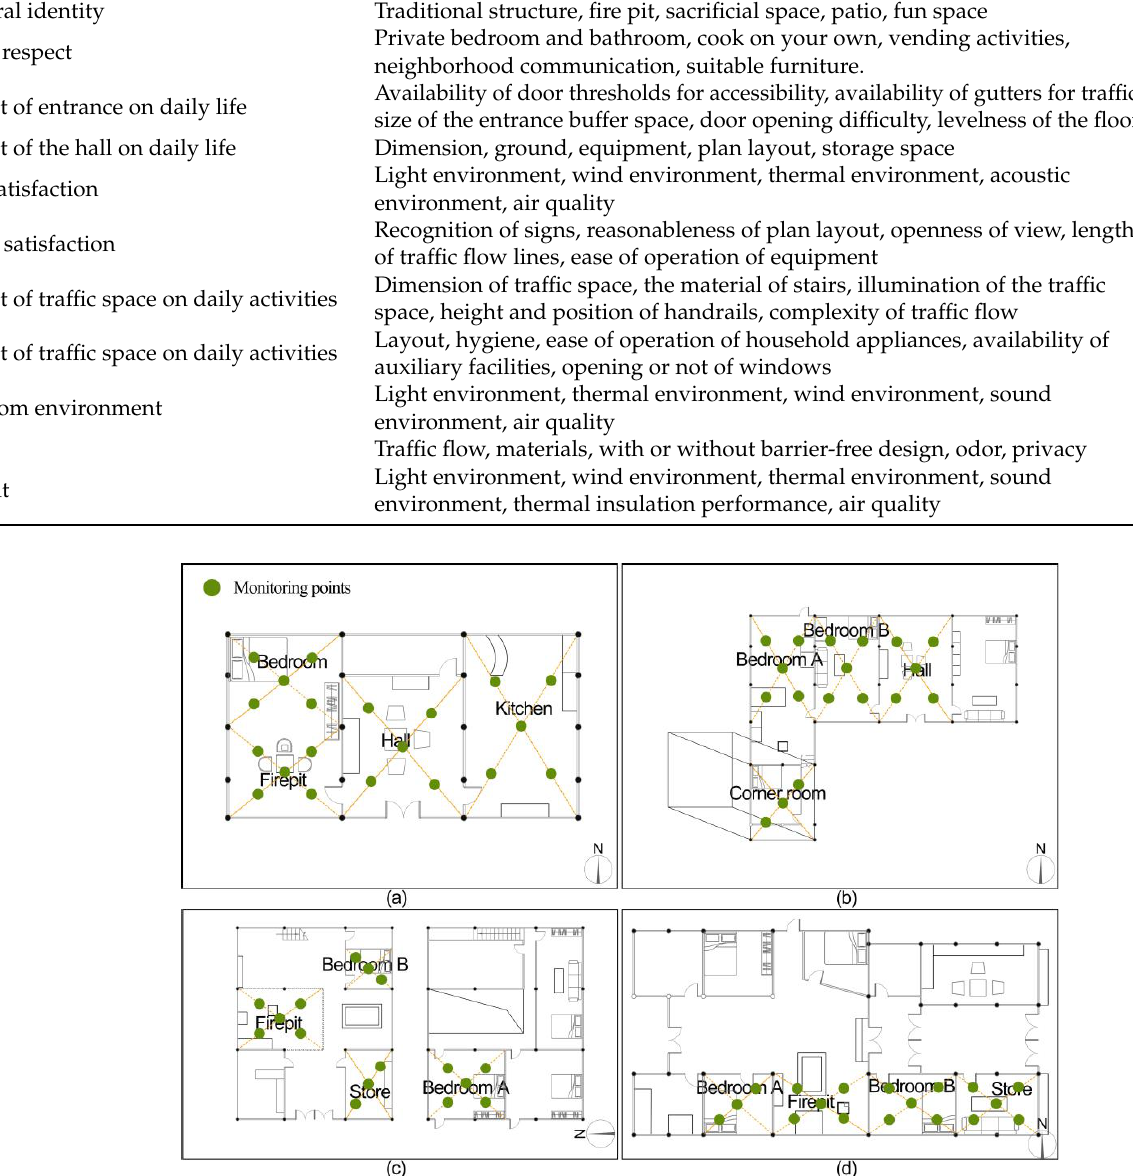
Figure 4. Indoor air quality monitoring points. ( a ) Zuozi dwelling [34], ( b ) L-shape dwelling [34], ( c ) front store and back house dwelling, ( d ) lower store and upper house dwelling.